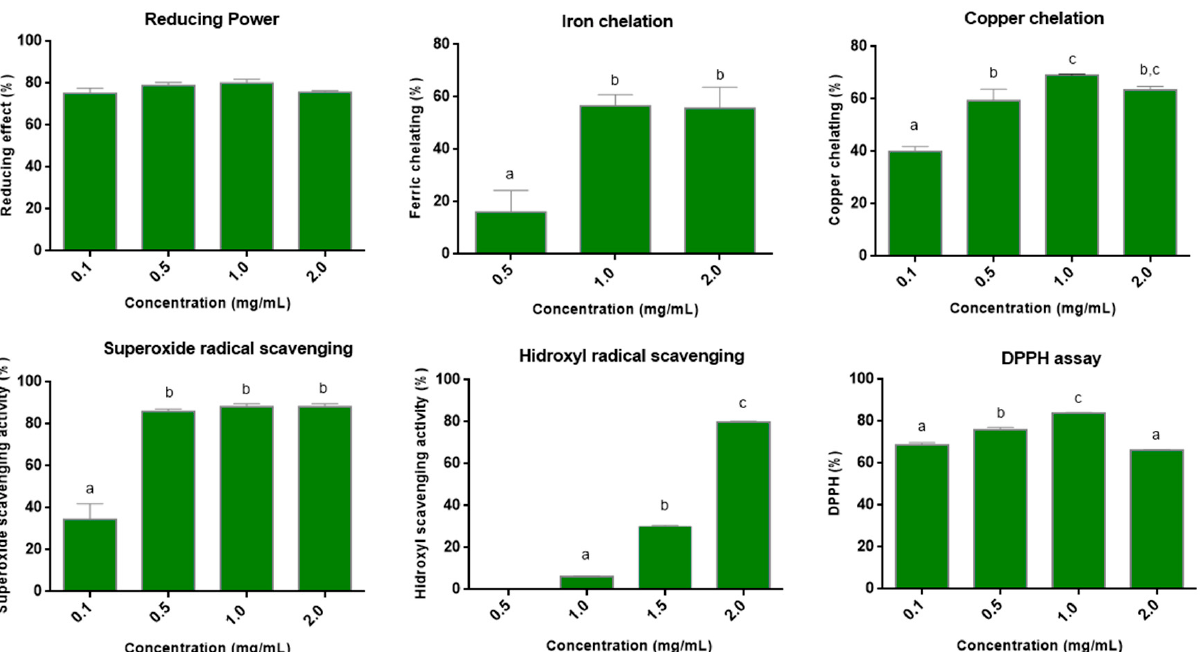
Figure 3. Antioxidant activity of B. trimera leaf extract (BT). Reducing power; Iron chelation; Copper chelation; Superoxide radical scavenging; scavenging of hydroxyl radicals and DPPH Assay. Assays were performed in triplicate, and data were analyzed using ANOVA and Tukey’s test ( p < 0.05). Different letters (a, b, c) correspond to significant differences in the statistical analysis.